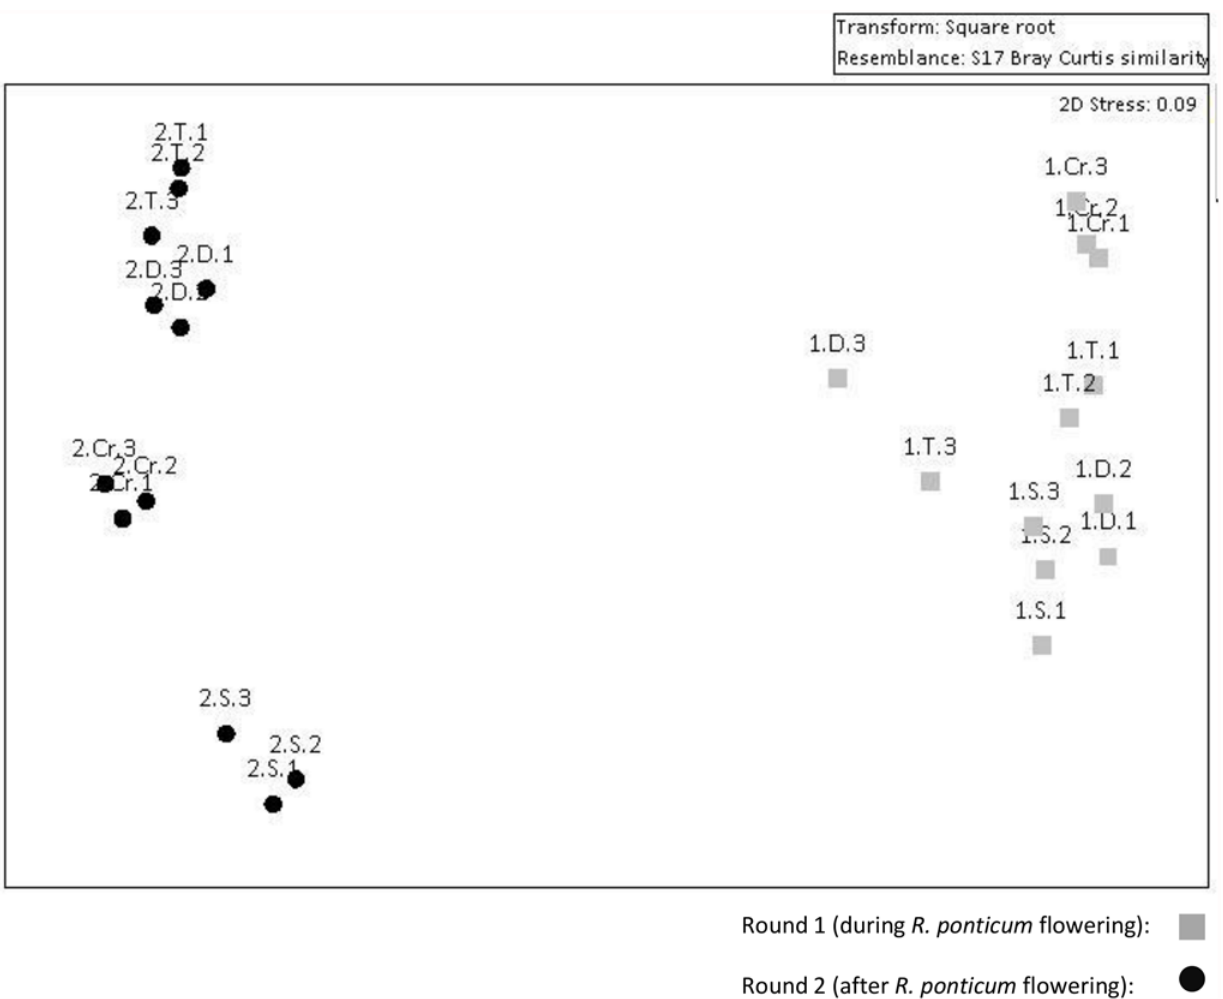
Fig 2. Non-metric Multi-Dimensional Scaling plot of floral abundance data Each point on the graph represents a replicate of floral abundance sampling, n = 3 replicates per site per sampling round. The closer the points, the more similar the identity and abundance of flowering plant species. Light grey squares represent sites sampled during R . ponticum flowering and black circles represent the same sites after flowering of the invasive species ceased. Label codes indicate the sampling round (1 or 2), the site name (C = Crossover, D = Dunran, S = Shankhill, T = Trooperstown), and the replicate (1, 2, or 3). Data were square root transformed to balance contributions of rarer and dominant flowering